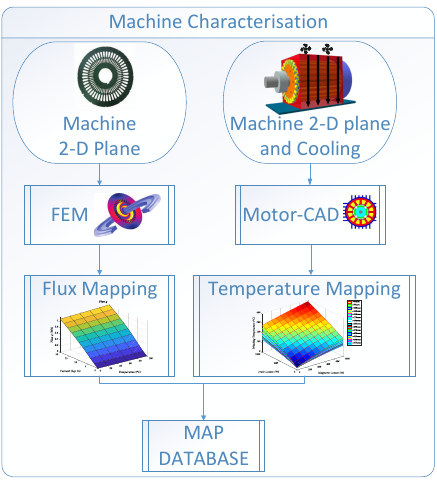
Figure 2. Map database